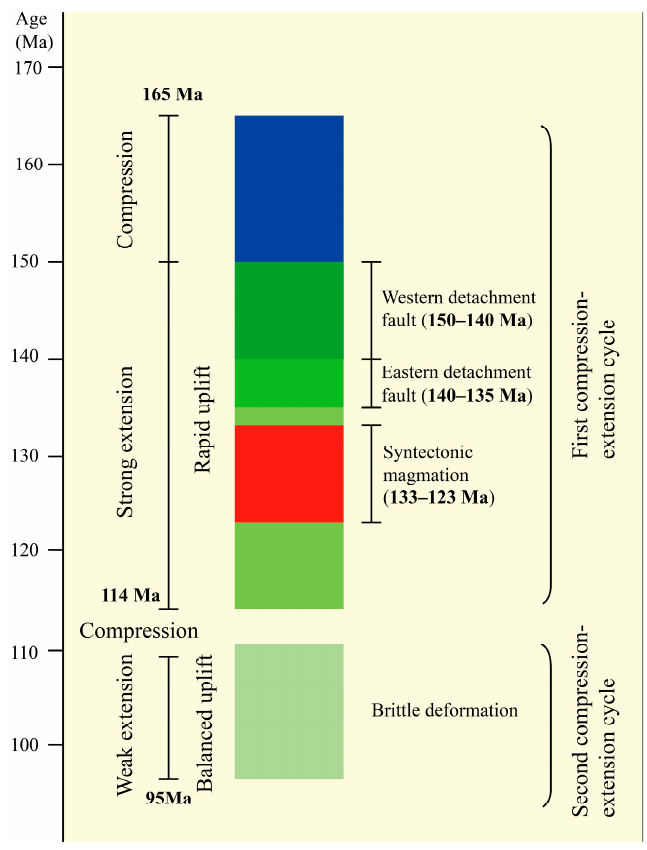
Figure 14. Late Mesozoic tectonic evolution sequence of the Lushan Massif.